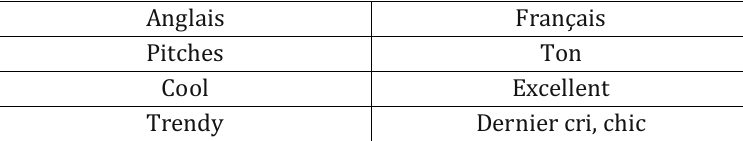
Tableu 2 Dans le monde du divertissement